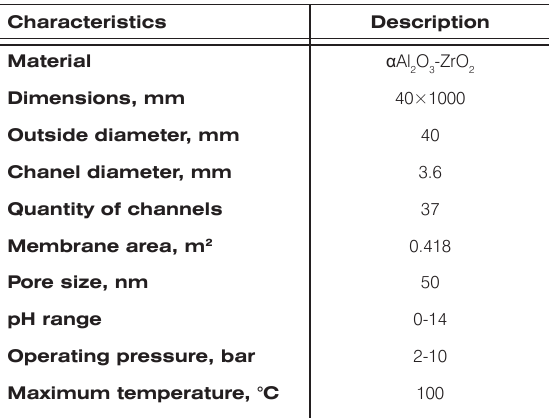
Table 1. Characteristics of ceramic